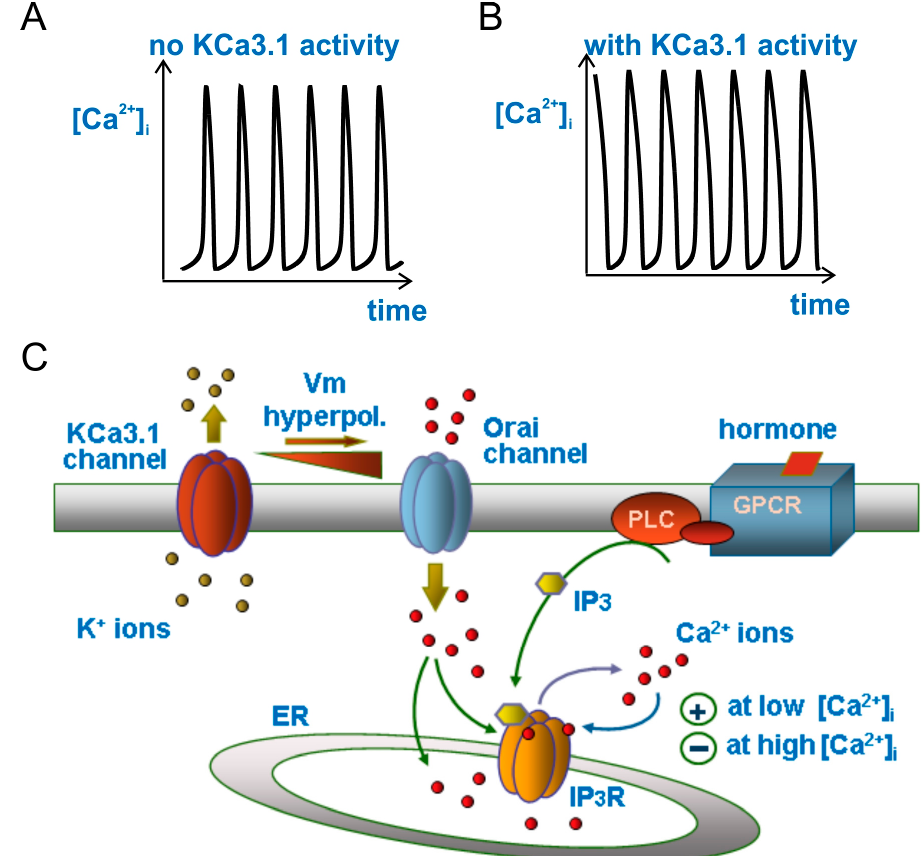
Figure 2. Modulation of Ca 2+ oscillations by the KCa3.1 channel. Drawing ( C ) illustrating the main ion fluxes generating or modulating the Ca 2+ oscillations in our model when the KCa3.1 channel is cut off ( A ) or introduced into the system ( B ). Please notice the much longer duration (width) and slightly higher amplitude of the Ca 2+ oscillations in the presence of KCa3.1 channels.